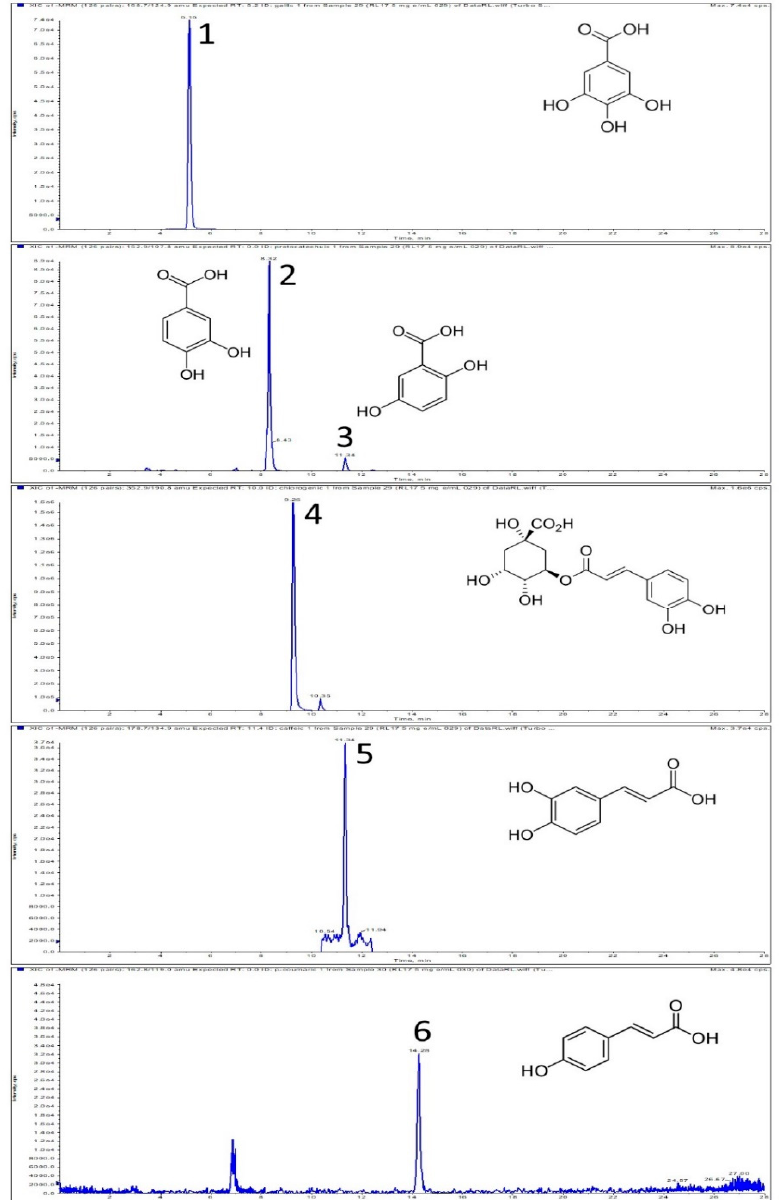
Figure 1. LC-MS (liquid chromatography mass spectrometry) chromatograms obtained in multiple reaction monitoring (MRM) mode of phenolic acids detected in R. luteum leaves (sample RL140C-M). Monitored MRM transition is given in the bracket: 1—gallic acid ( m / z 168.7 → 124.9), 2 and 3—protocatechuic and gentisic acids, respectively ( m / z 152.9 → 107.8). 4—5- O -ca ff eoylquinic acid ( m/z 352.9 → 190.8), 5—caffeic acid ( m/z 178.7 → 134.9), 6— p -coumaric acid ( m/z 162.8 → 119). Un-numbered peaks represent uncharacterized constituents.